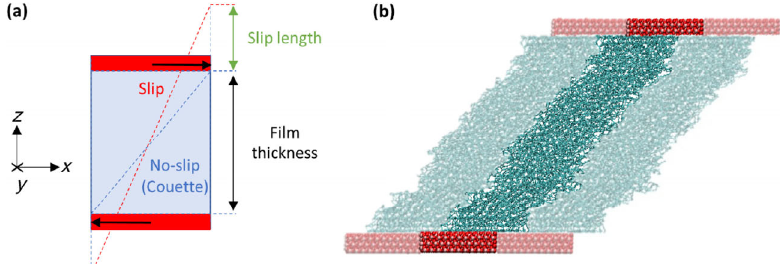
Fig. 3 Schematic diagram showing the definition of the slip length from NEMD simulations (a) and image of NEMD simulation with boundary slip with periodic images shown as translucent